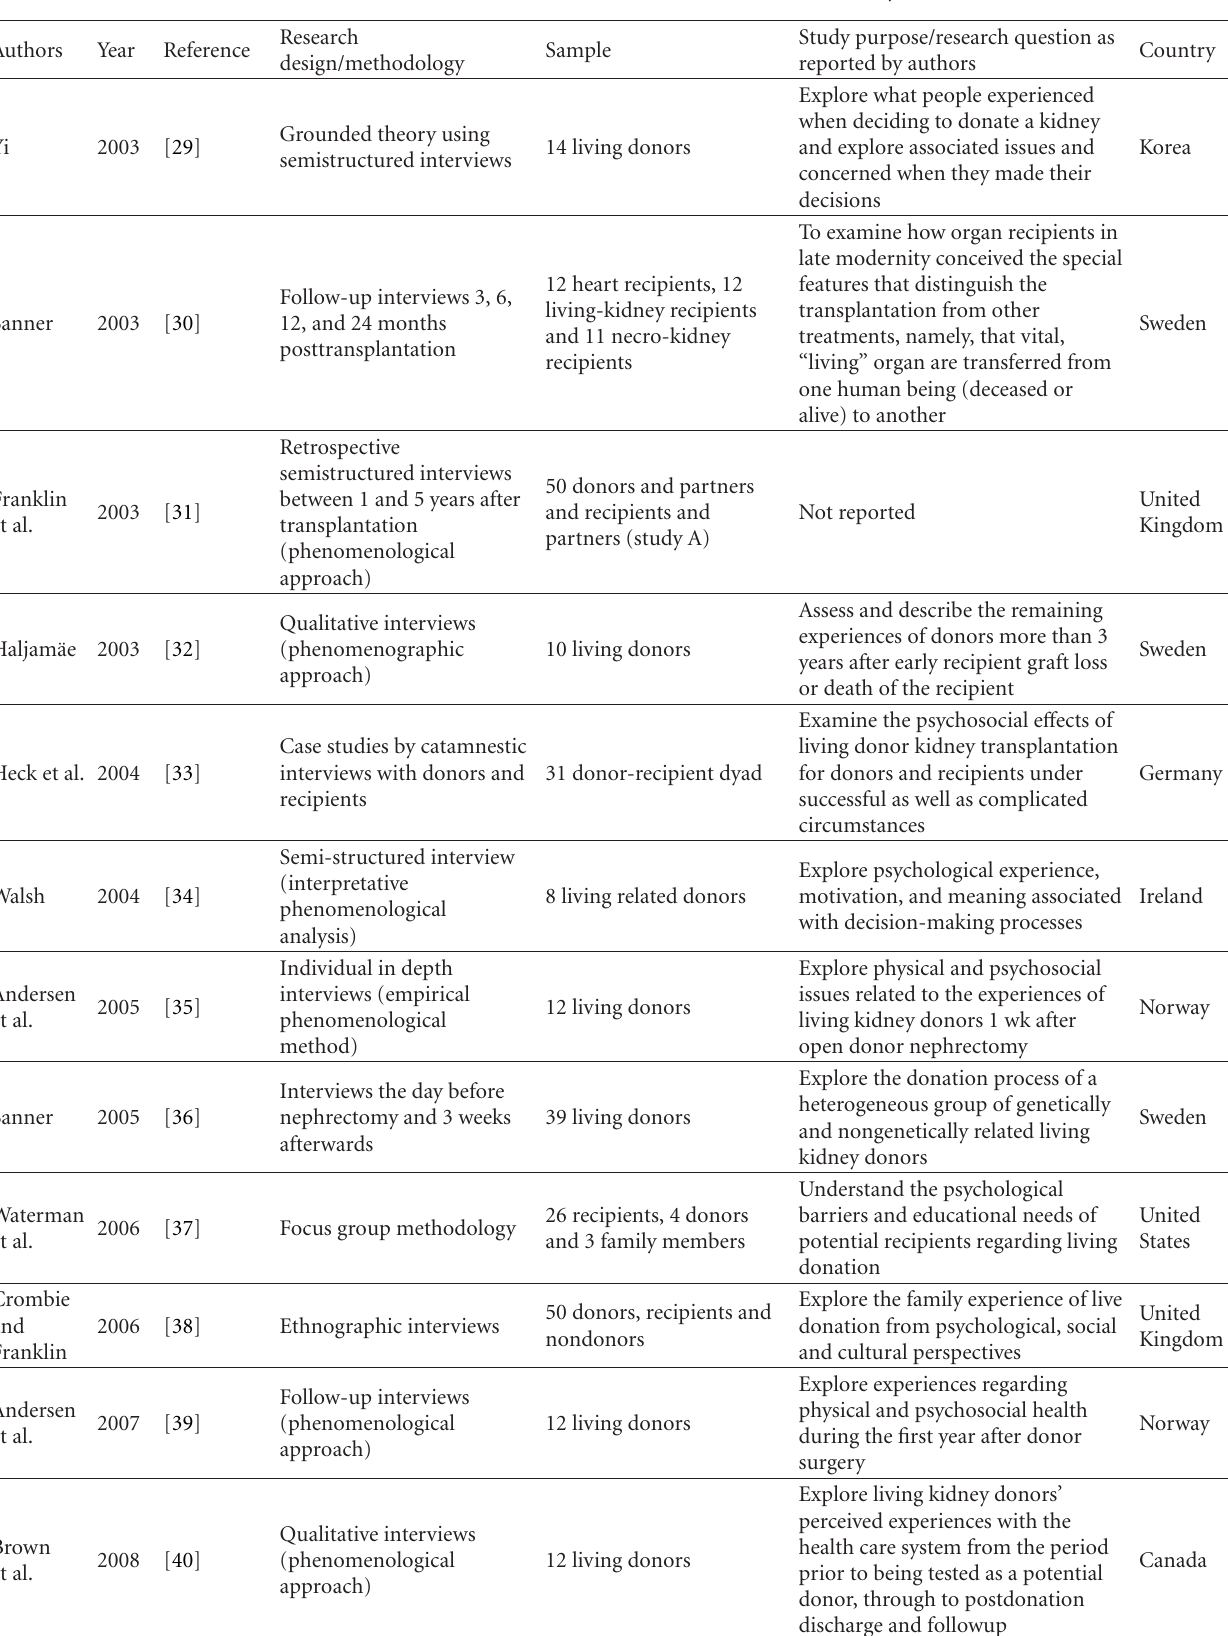
Table 1: Characteristics of studies included in the